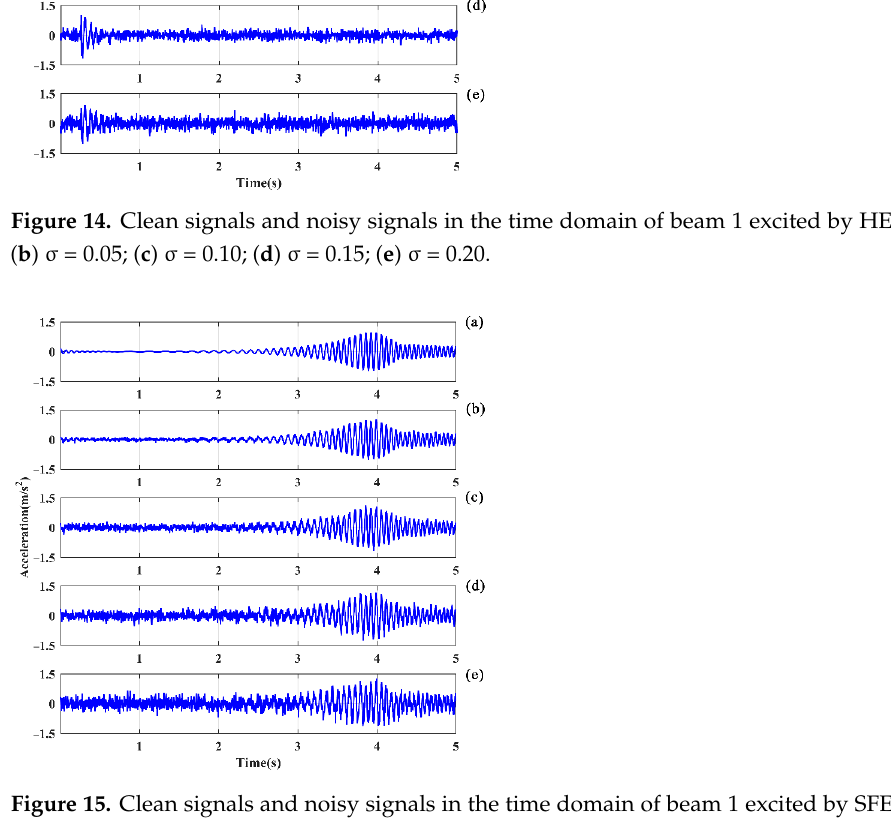
Figure 16. Identification of LPF in frequency spectrums of noisy signals excited by HE: ( a ) σ = 0.05; ( b ) σ = 0.10; ( c ) σ = 0.15; ( d ) σ = 0.20.